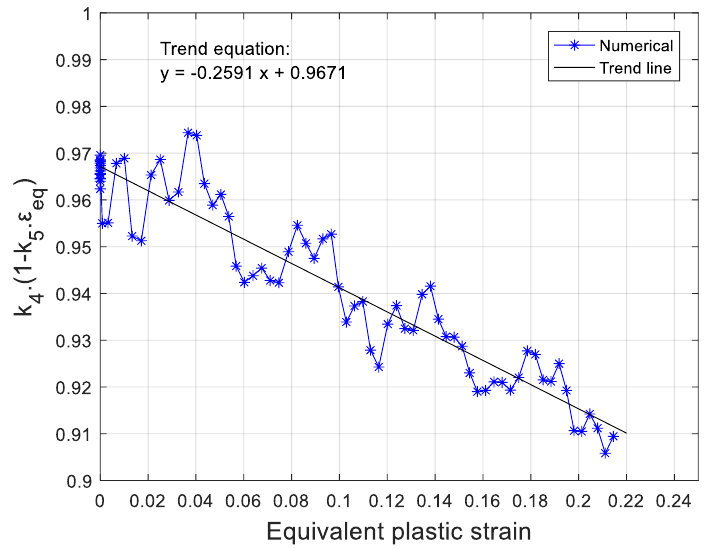
Figure A5. Identification of coefficients 𝑘 4 and 𝑘 5 with the curve obtained from equation (A1) starting at 0.9 on the y-axis.